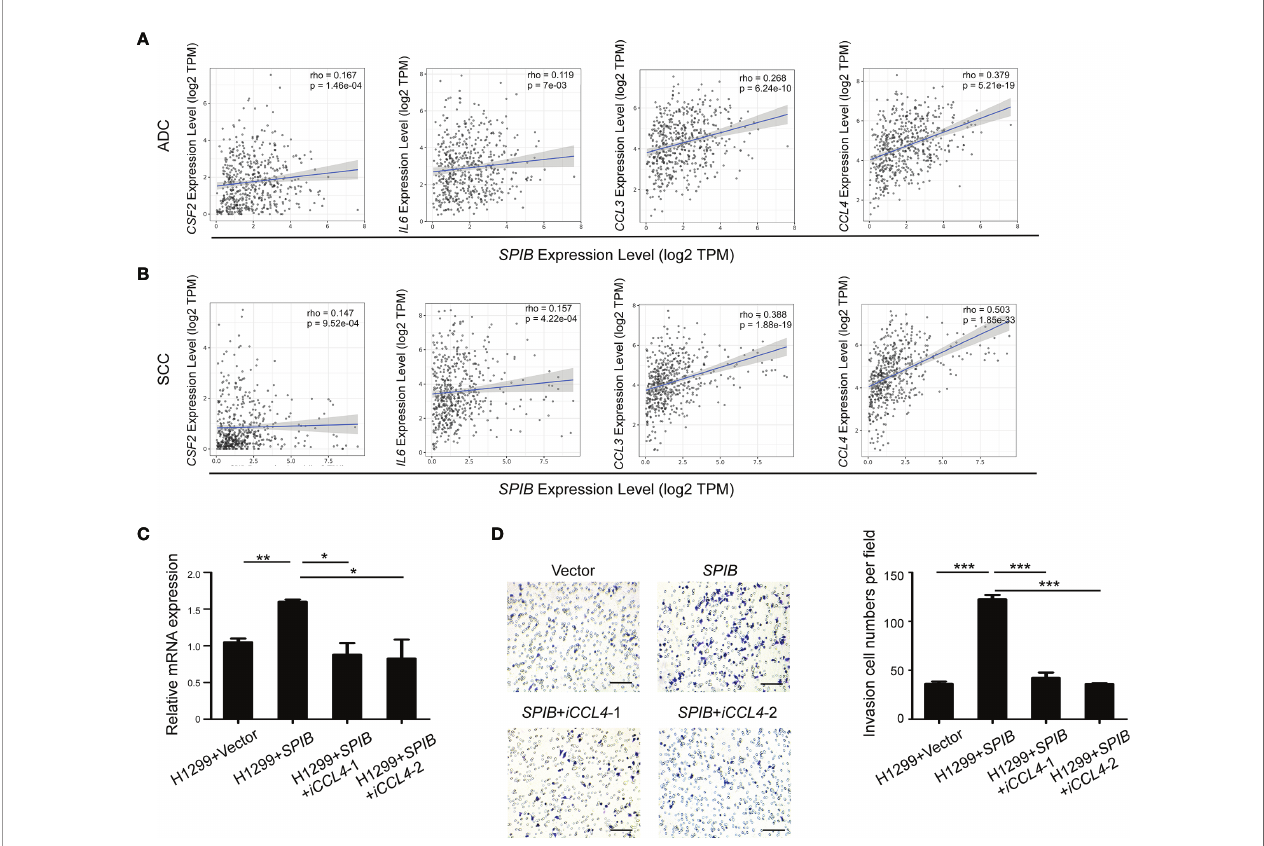
FIGURE 6 | CCL4 knockdown inhibits Spi-B-induced macrophage recruitment. (A , B) The correlation between the expression of SPIB and CSF2, IL6, CCL3 and CCL4 are shown in ADC (A) and SCC (B) . (C) CCL4 silencing ef fi ciency in H1299 cells expressing SPIB veri fi ed by RT-qPCR. Mean ± SD. *P < 0.05. **P < 0.01. (D) Recruitment assay in H1299 cells co-transfected with SPIB and CCL4 -ShRNA. Left, representative transwell images of the recruited macrophages. Right, relative fold changes of recruited macrophages in each image fi eld (200×). Mean ± SD. ***P < 0.001. Scale bars, 100